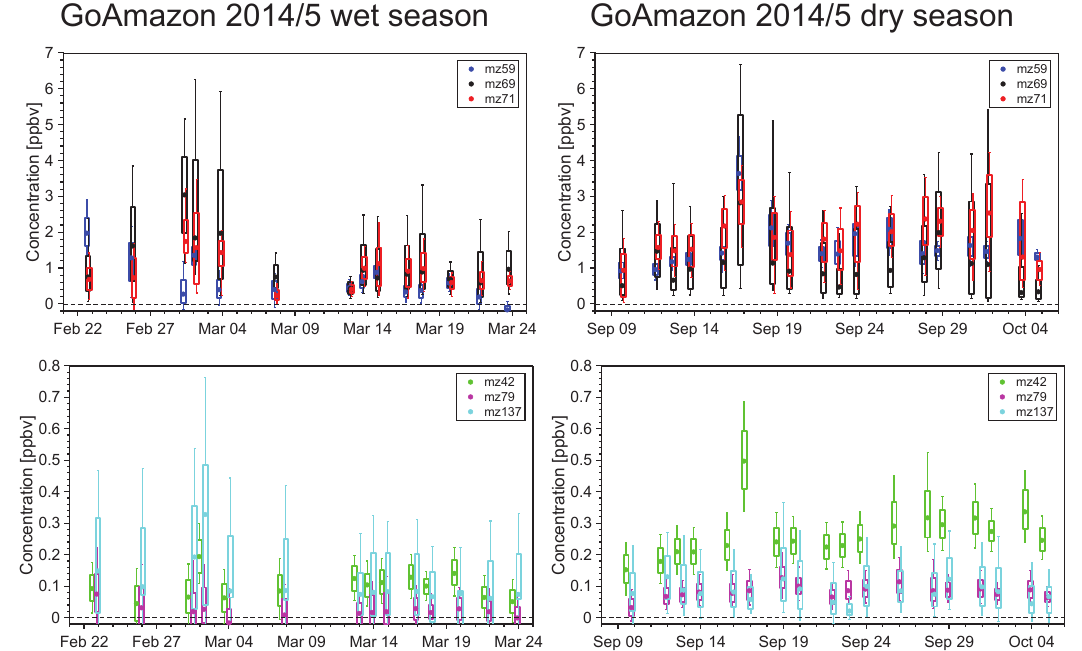
Figure 3. Box-and-whisker representations of the G-1 PTR-MS data for both the wet and dry seasons. Boxes represent the quartiles, with whiskers extending to 10% and 90% and the median values shown as dots. Note the scale change between the top and bottom panels.